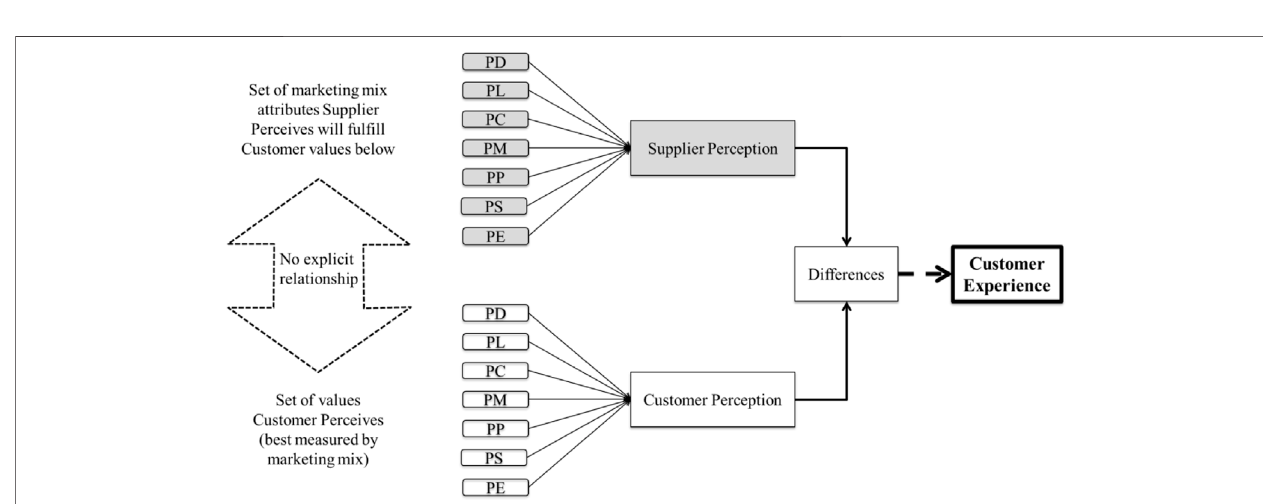
FIGURE 2 | Conceptual model for the supplier/customer.